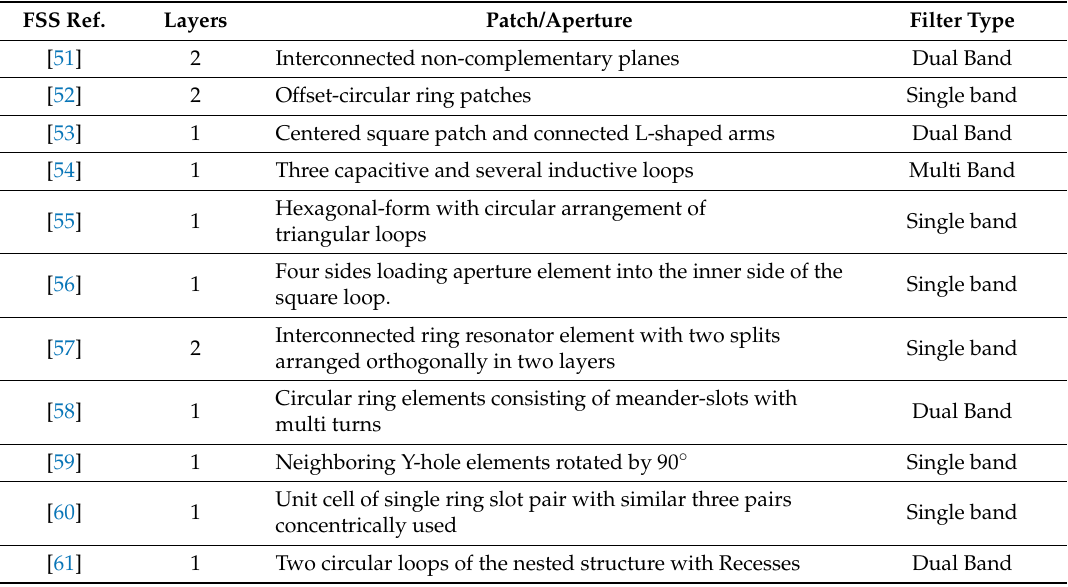
Table 2. Different types of